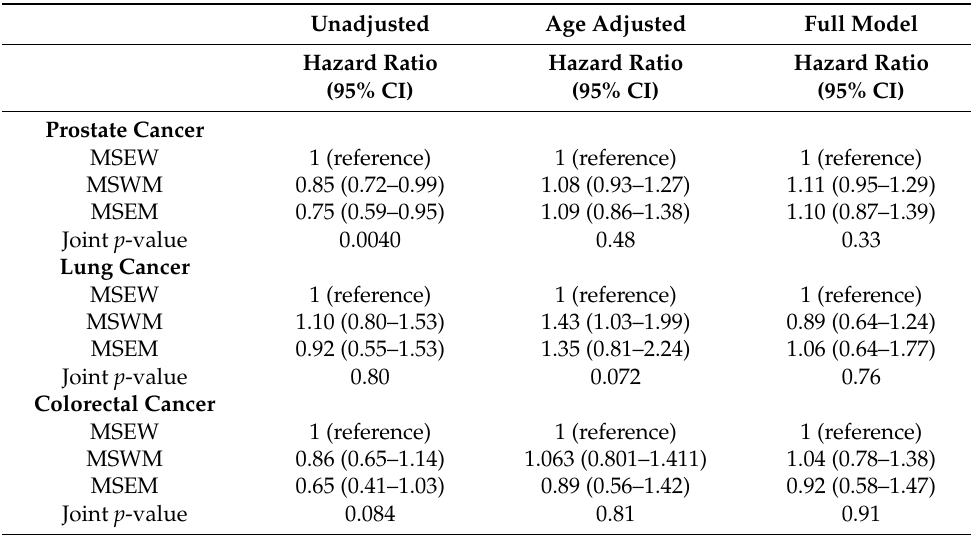
Table A4. Models of prostate, lung, and colorectal cancer in